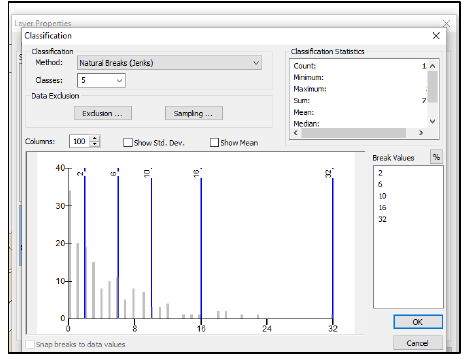
Figure 1. Classification of TB localities cases.